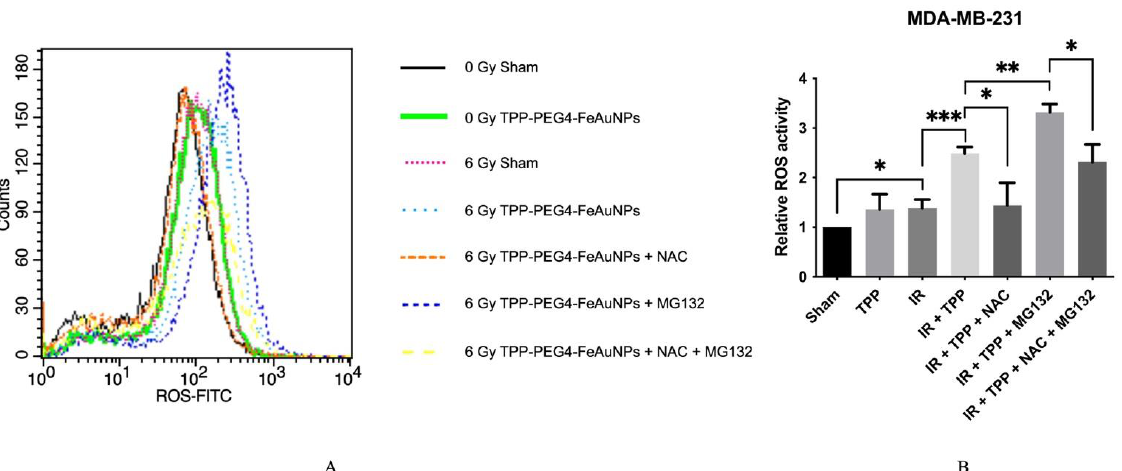
Figure 6. Apoptosis assay of 4T1 ( A,B ) and MDA-MB-231 ( C,D ) TNBC cells after treatment with NGL-PEG4-FeAuNPs, PEG4-FeAuNPs and TPP-PEG4-FeAuNPs, or sham treatment for 24 h followed by an irradiation with 6 Gy. Apoptosis was determined by flow cytometry using Annexin V-FITC/PI staining. Significance: * p ≤0.05, ** p ≤0.01; results show the mean values ± SD of 3 independent experiments.